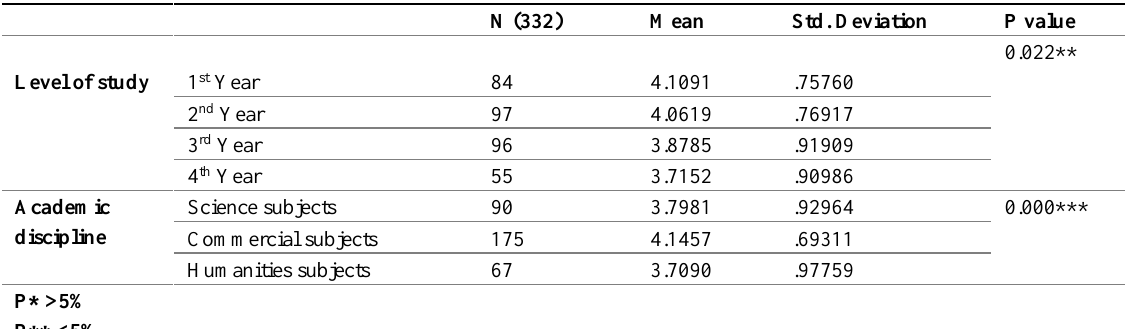
Table 2: ANOVA test of level of study, academic discipline and entrepreneurship intention N (332) Mean Std. Deviation